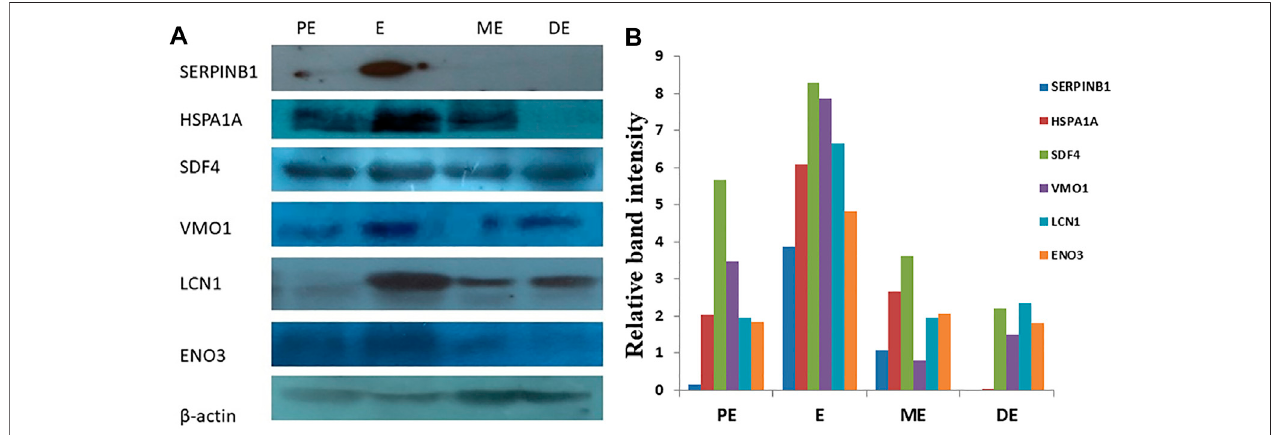
FIGURE 11 | Western blot analysis for validation of differentially expressed upregulated proteins. (A) Over-expression of SERPINB1, HSPA1A, SDF4, VMO1, LCN1,andENO3,duringestrus(E)comparedtoproestrus(PE),metestrus(ME),anddiestrus(DE)stagesofthebuffaloestrouscycle. (B) Bandintensitywasnormalized against beta-actin as an internal control.